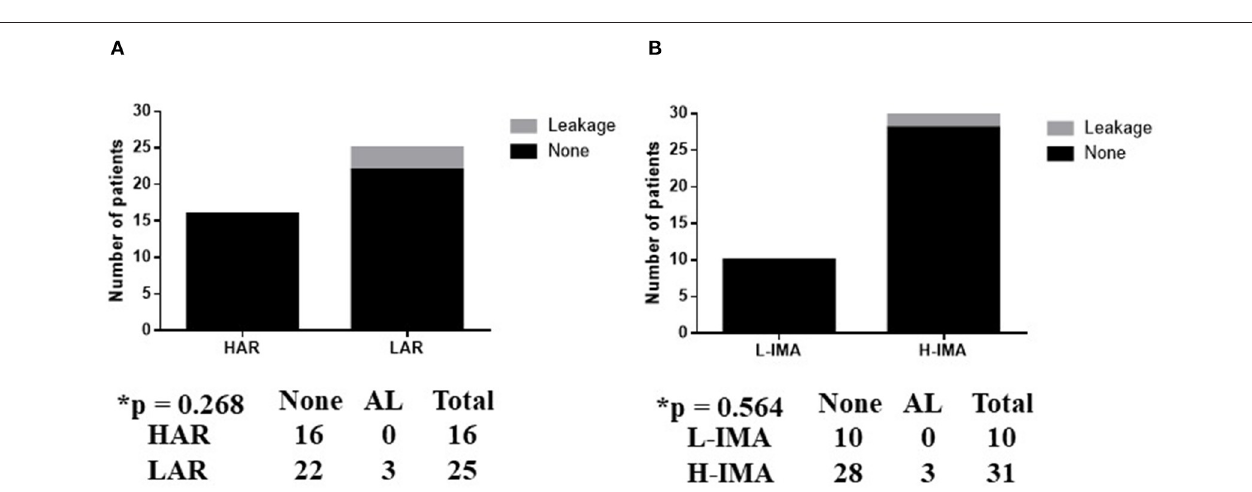
FIGURE 4 | (A,B) Association between anastomotic leakage in anterior rectal resection and surgery type. L-IMA, low ligation of the IMA; H-IMA, high ligation of the IMA; LAL, low anterior rectal resection; HAR, high anterior rectal resection. Calculated by Fisher’s exact 2 × 2 contingency